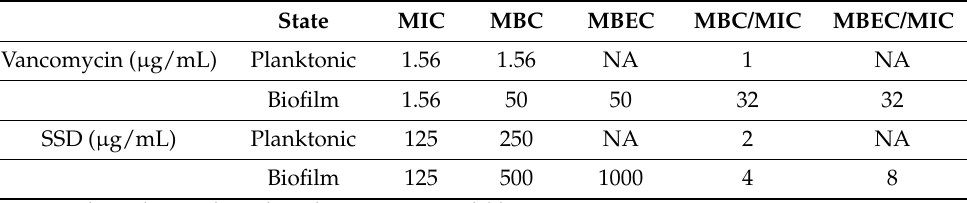
Table 3. The effect of vancomycin and SSD on a clinical isolate of S. aureus .